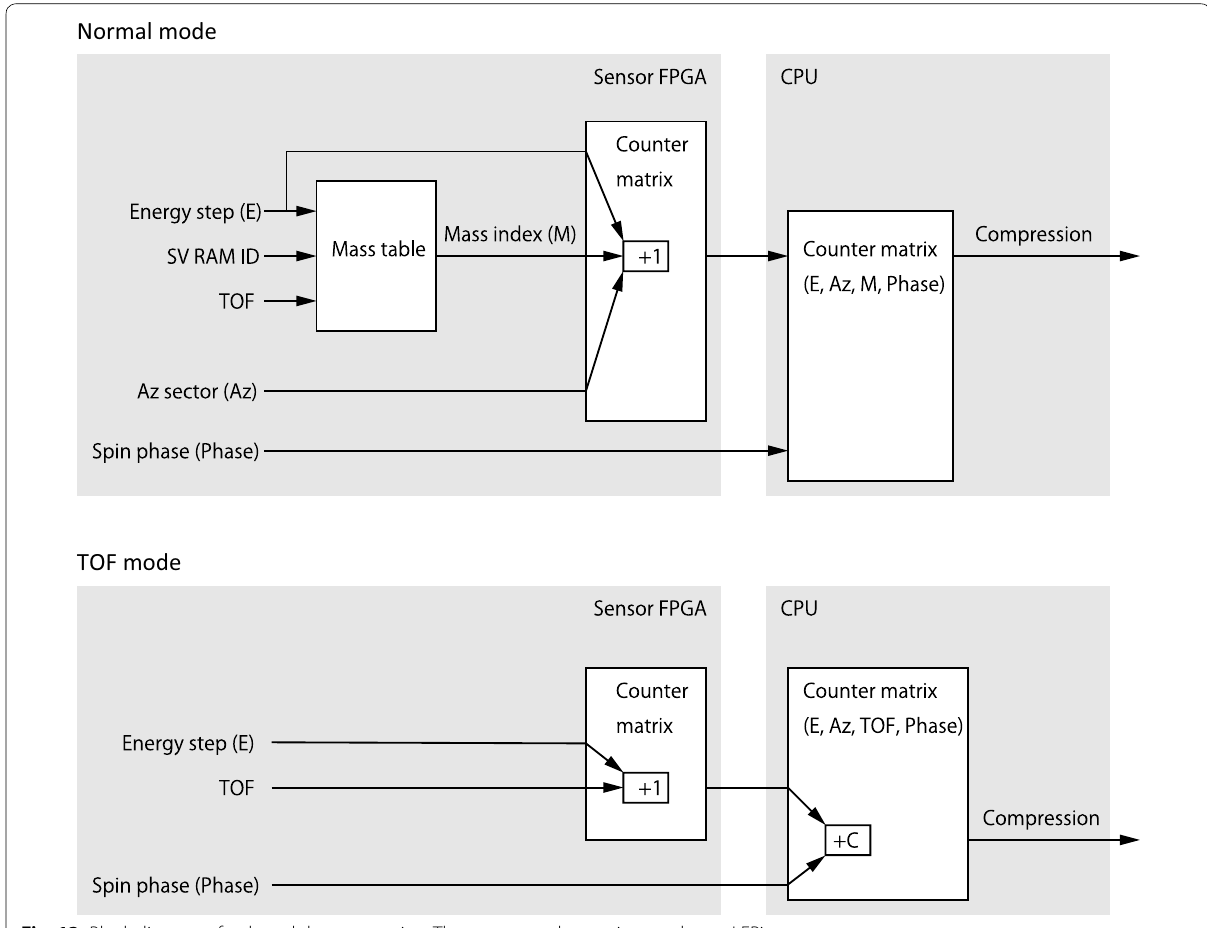
Fig. 13 Block diagram of onboard data processing. There are two observation modes on LEPi